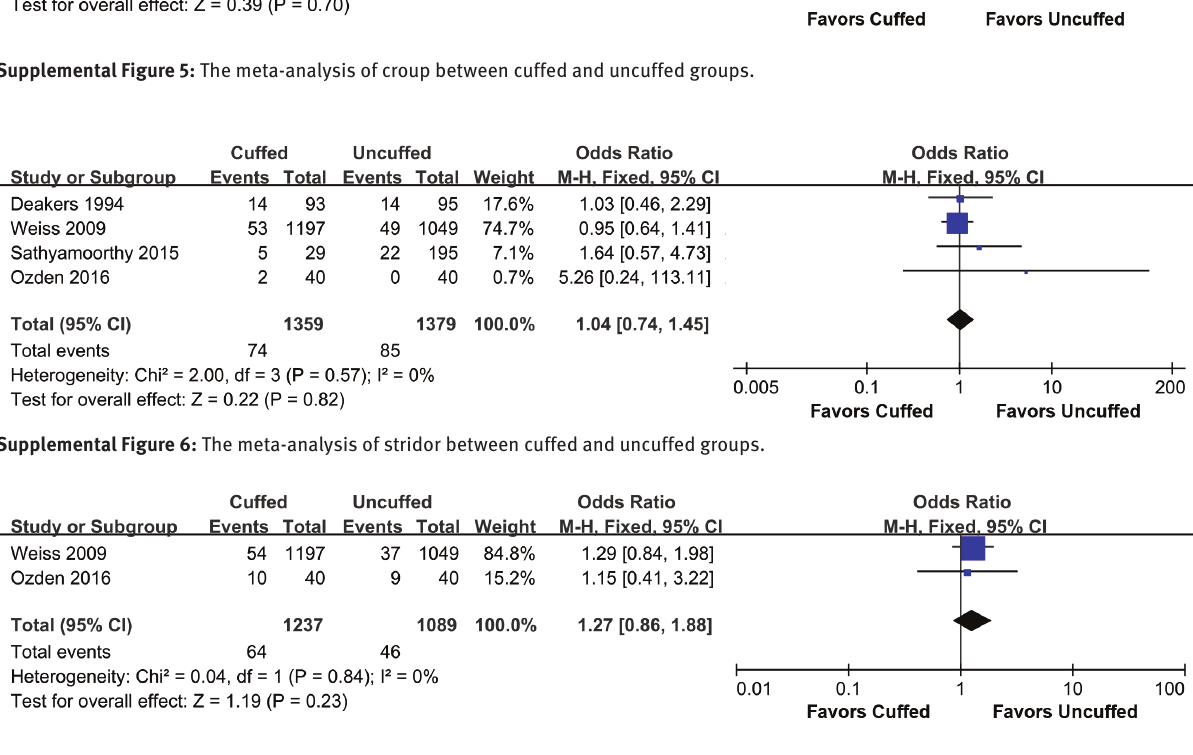
Supplemental Figure 7: The meta-analysis of laryngospasm between cuffed and uncuffed